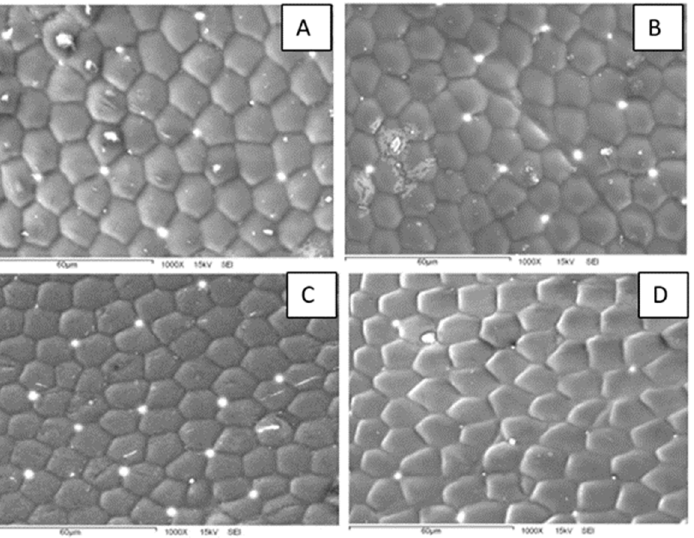
Figure 4. SEM micrographs of the polygon arrays in the background surfaces of E. eschscholtzii individuals. ( A , B ) Specimens from the HMO collecting site; ( C , D ) Specimens from KB.